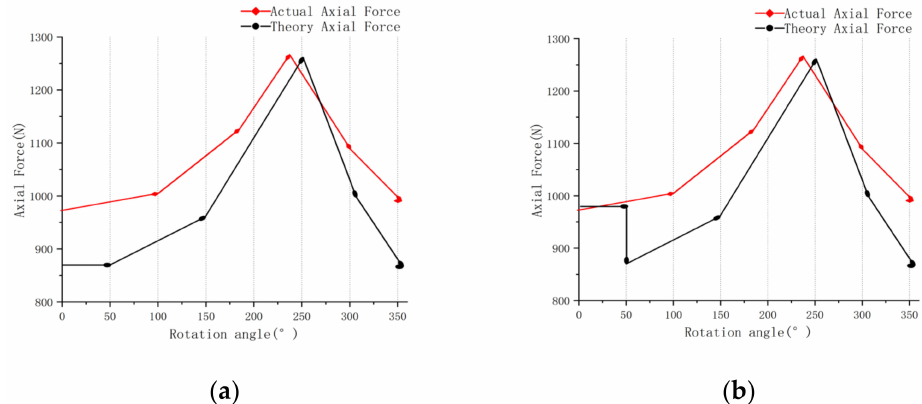
Figure 5. Segmented tracking process diagram: ( a ) the first interval tracks the initial state; ( b ) tracking end state of the first